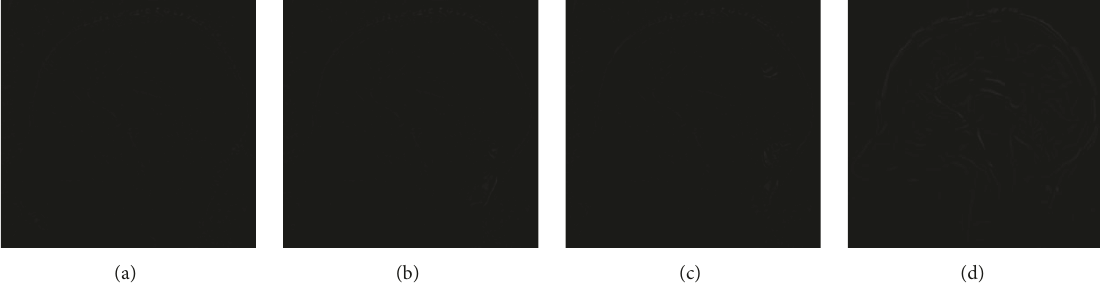
Figure 6: Difference between registration result and reference image. (a) Our method, (b) diffeomorphic demons, (c) additive demons, and (d) active demons.